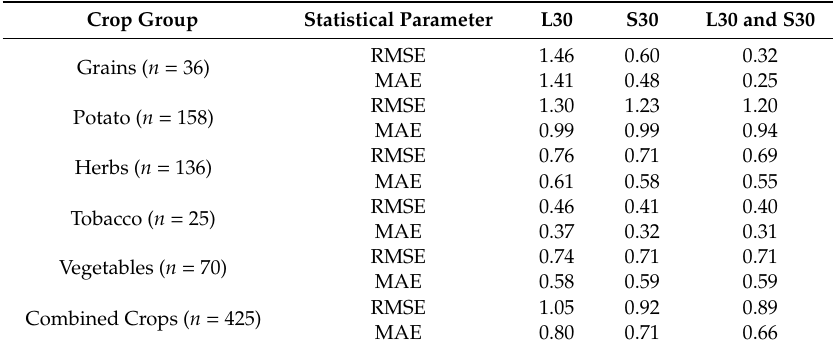
Table 8. Statistical comparison between modeled and observed LAI separated by satellite type: L30, S30, and L30 and S30 combined, the modeled LAI is obtained using the LAI-EVI2 empirical relationships displayed in Table